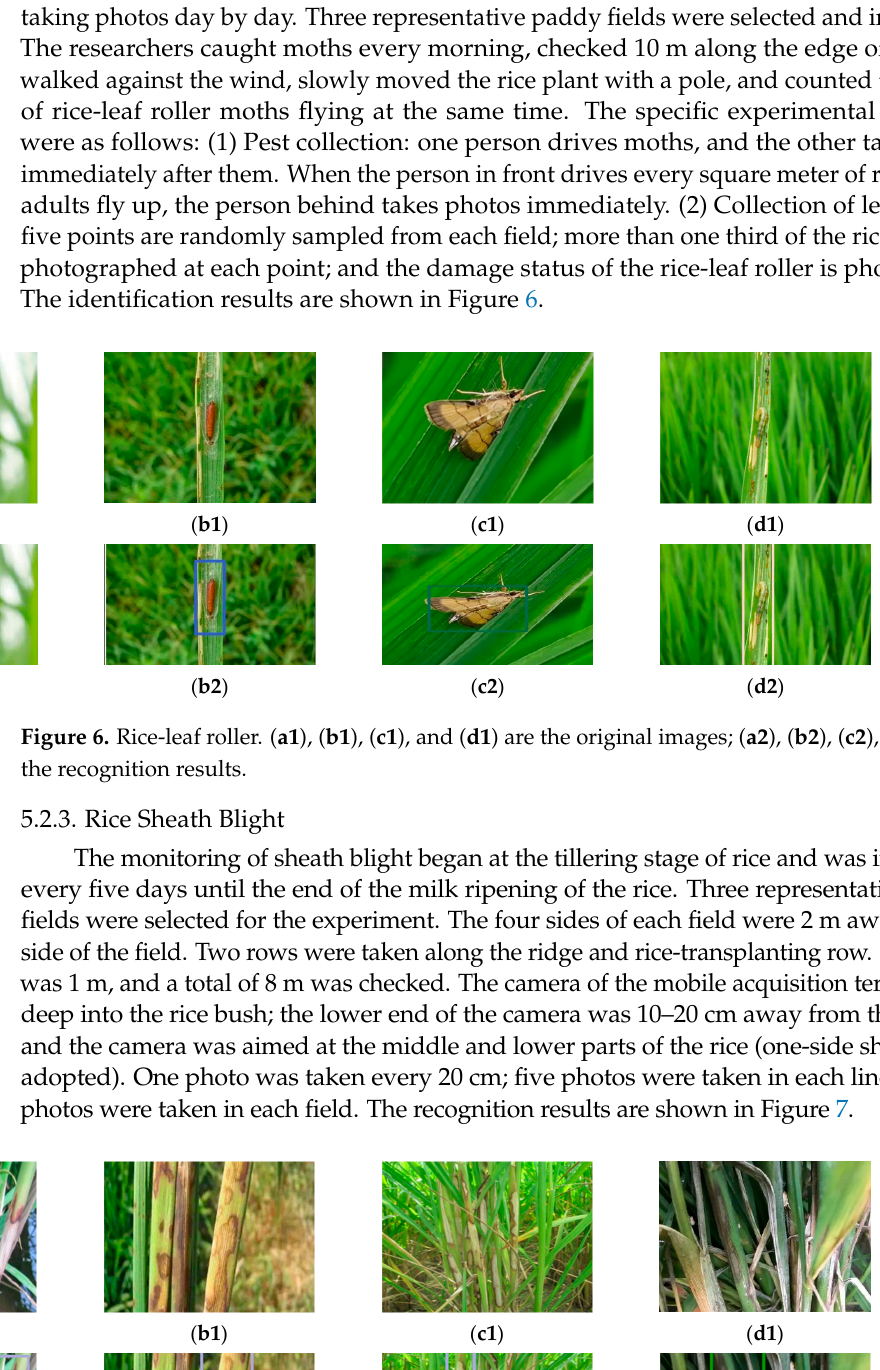
Figure 5. Rice planthopper. ( a1 ), ( b1 ), ( c1 ), and ( d1 ) are the original images; ( a2 ), ( b2 ), ( c2 ), and ( d2 ) are the recognition results.